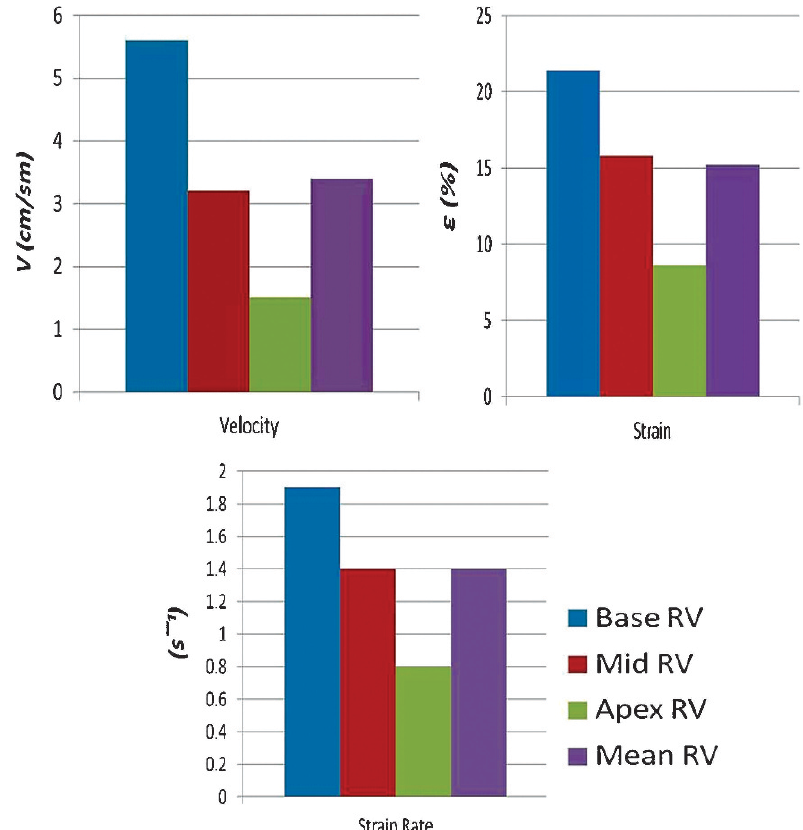
Figure 2 - Myocardial velocity, strain, and strain rate values of the basal, mid, and apical segments of the right ventricle showing RV involvement from the base to the apex in Ami